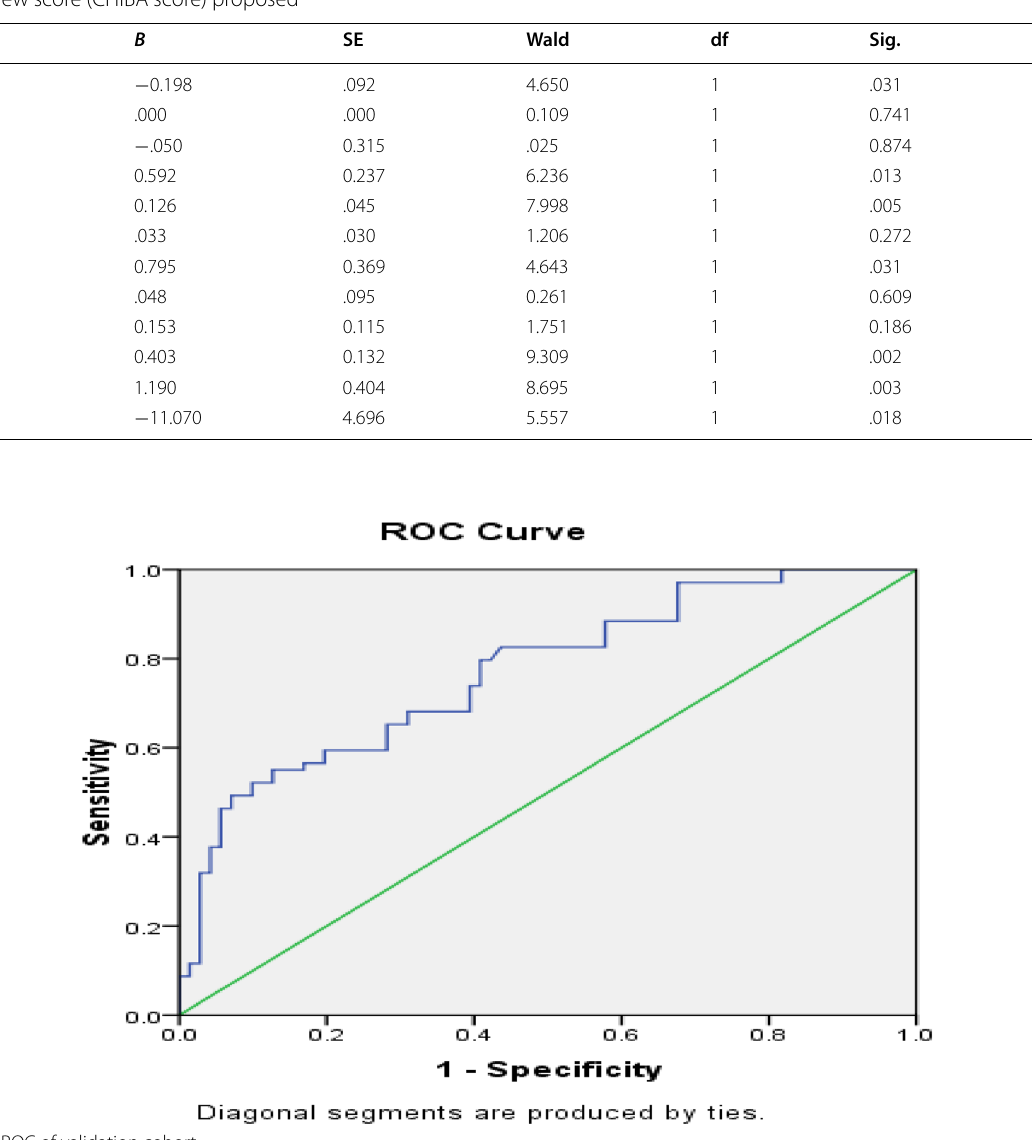
Fig. 3 AUROC of validation cohort